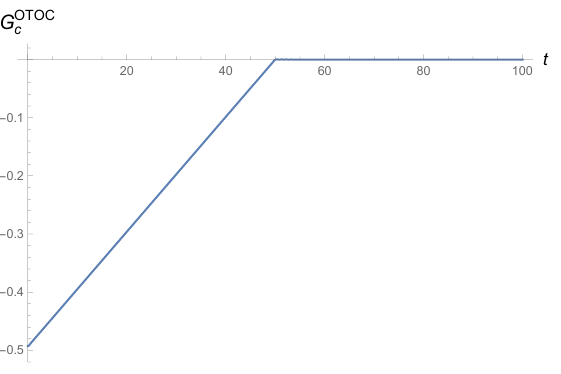
Figure 4 . A plot of the late time ( t (cid:29) (cid:12) ) connected OTOC at large N; N f , (cid:12) = 0 : 1. It exhibits a ramp-plateau